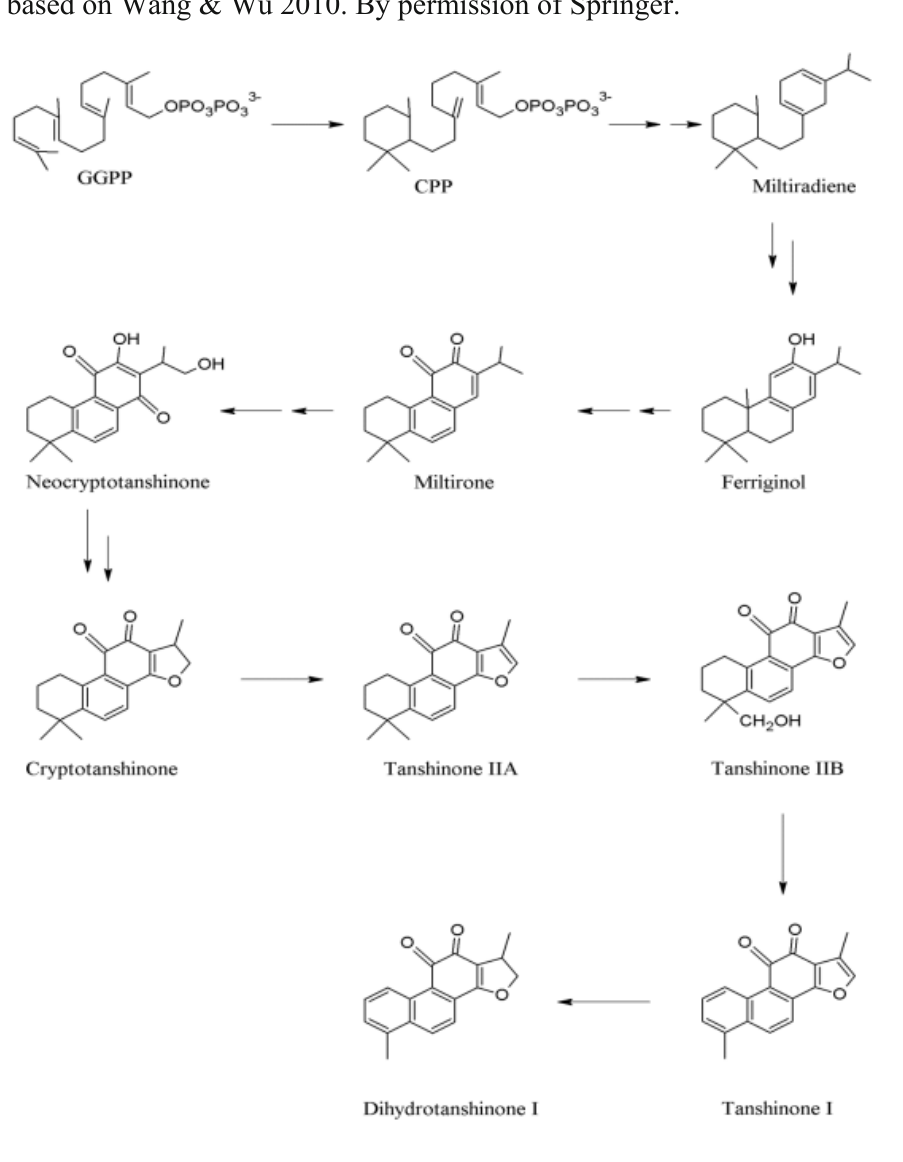
Figure 2. Proposed biosynthetic pathways of tanshinones in Salvia miltiorrhiza [48]. Modified based on Wang & Wu 2010. By permission of